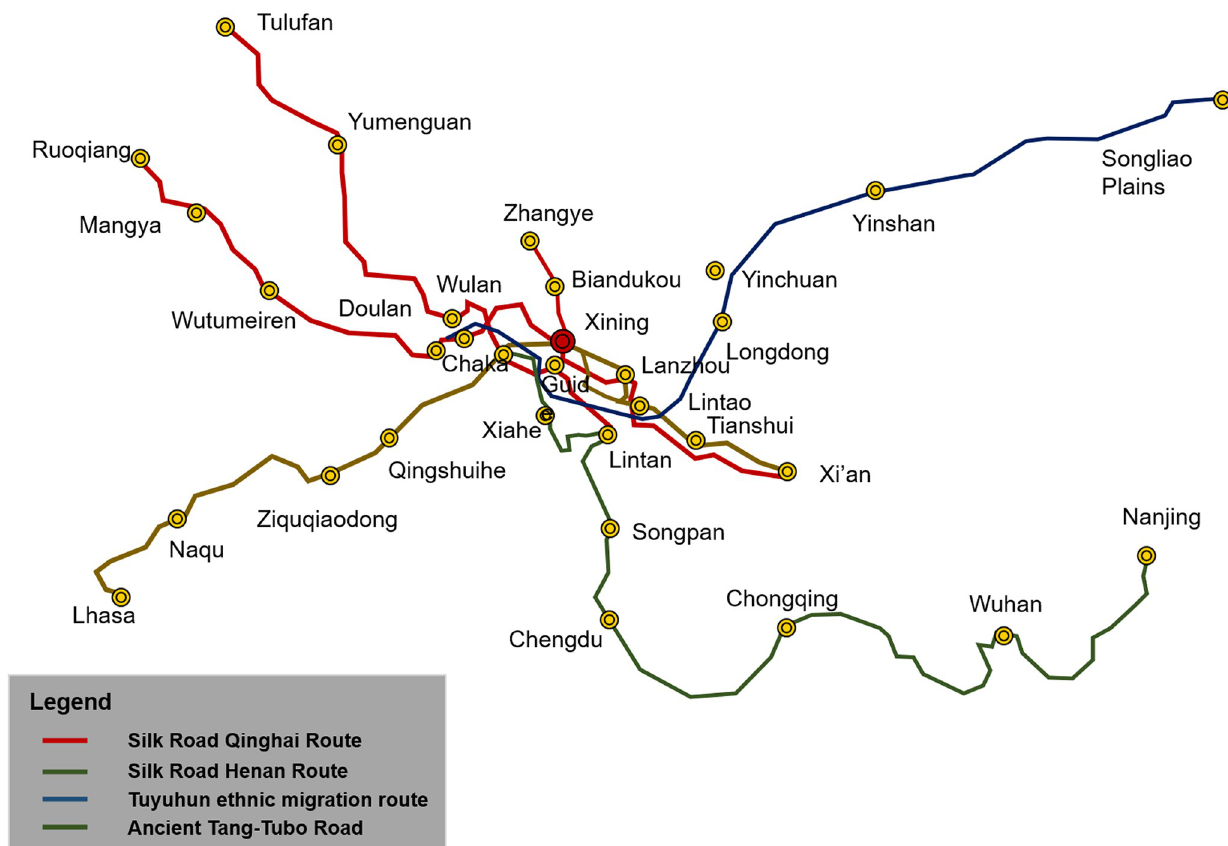
Fig 1. Ancient traffic routes in Qinghai province (202 B.C.–907 A.D.).